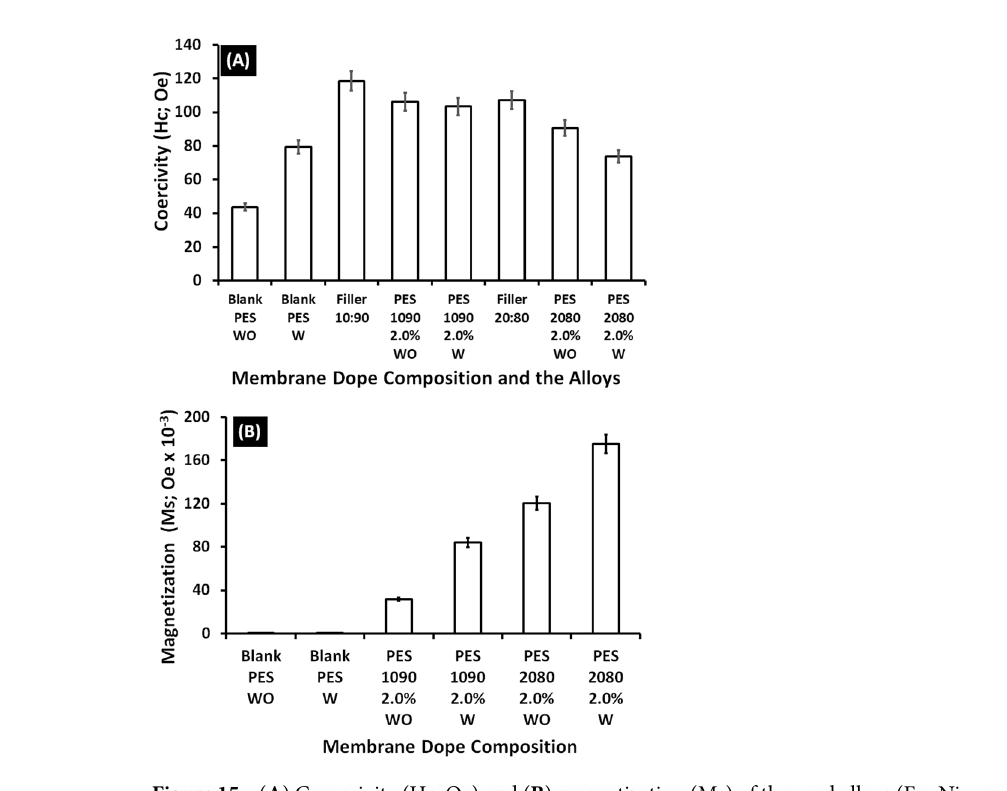
Figure 15. ( A ) Coerceivity (Hc; Oe) and ( B ) magnetization (Ms) of the used alloys (Fe 10 Ni 90 and Fe 20 Ni 80 ), the bank PES and the magnetic mixed matrix PES membranes (PES 1090 2.0% and PES 2080 2.0%) without and with using 0.1 wt% of Lithium chloride additive in the membrane